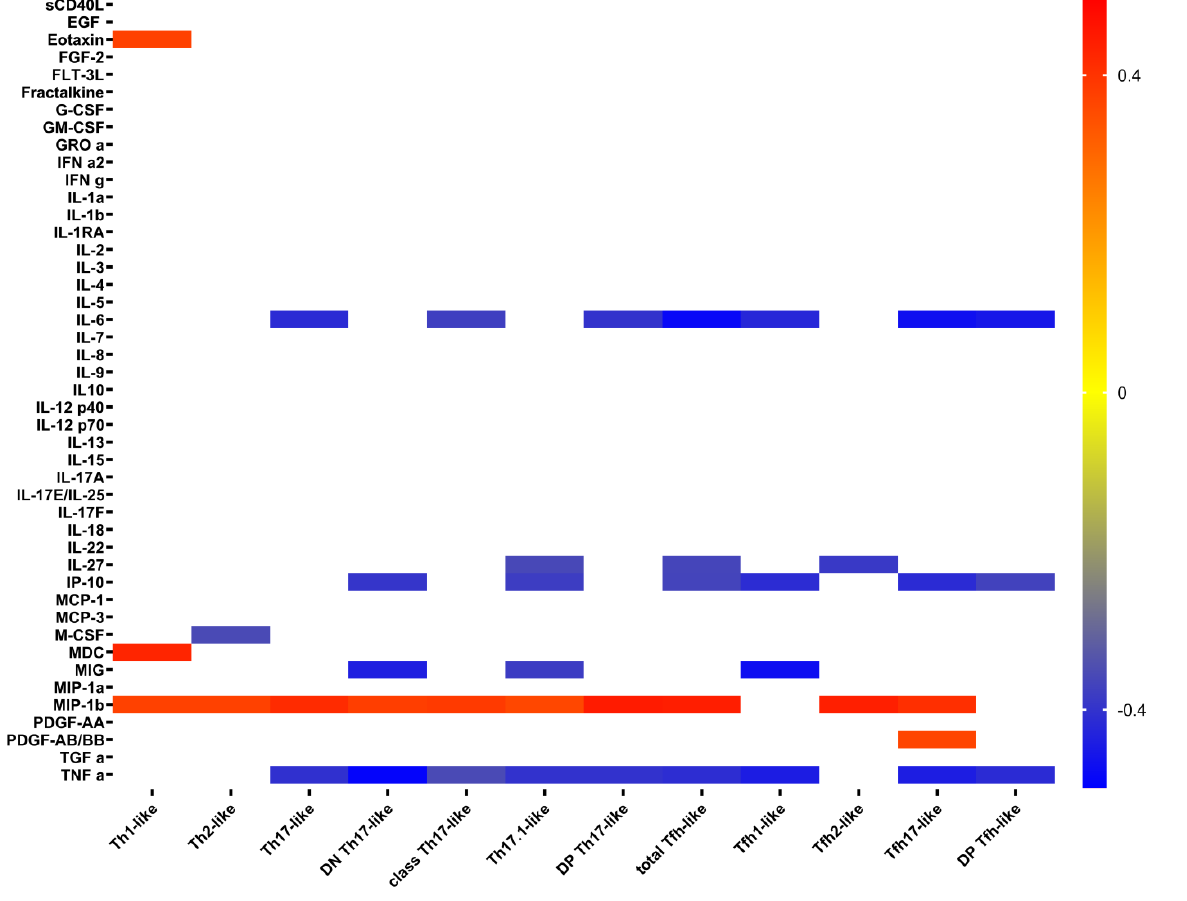
Figure 5. Heat map of correlations between cytokine levels and absolute count of Th-cell subsets in patients with COVID-19. Color scale bar shows a range of correlation coefficients (r). The red color represents a high positive correlation, decreasing to the blue color bar, which represents a negative correlation.